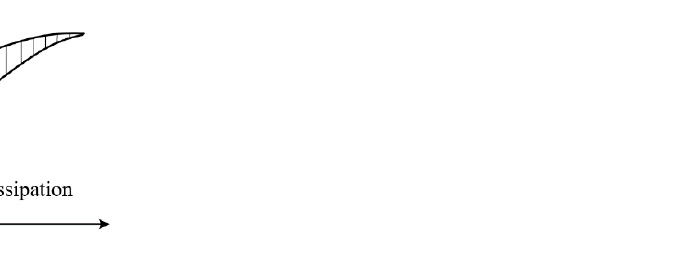
Figure 9. Sketch of energy dissipation under elastic and micro-elastic deformation stages.